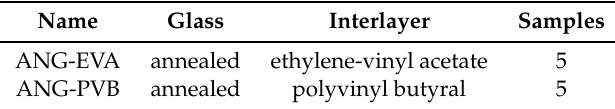
Table 5. Material composition of the layers in the tested specimens.